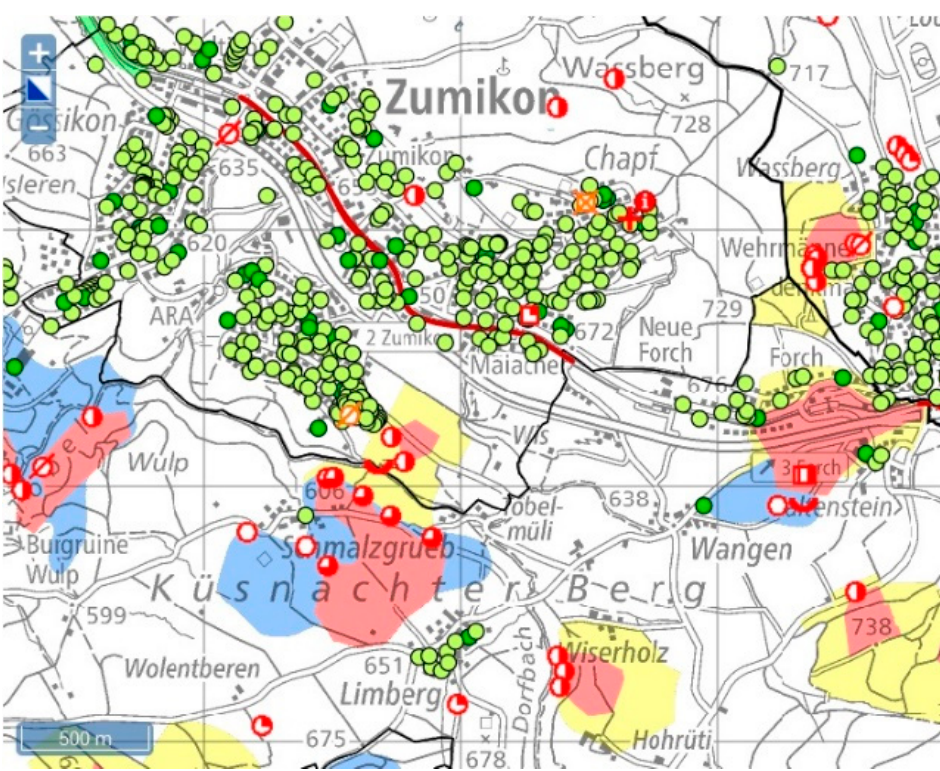
Figure 25. Details of the BHE map of Canton Zurich, Switzerland. Colored areas: Red, blue are groundwater protections zones A, B, respectively (no BHEs installable, yellow: BHEs possible, with restrictions). Green circles are BHEs (full: with geologic profile, empty: without). Red squares are groundwater wells, red circles: spring captures (the fuller the symbol, the higher the flow-rate) From http://www.erdsonden.zh.ch, accessed on 7 September 2022.